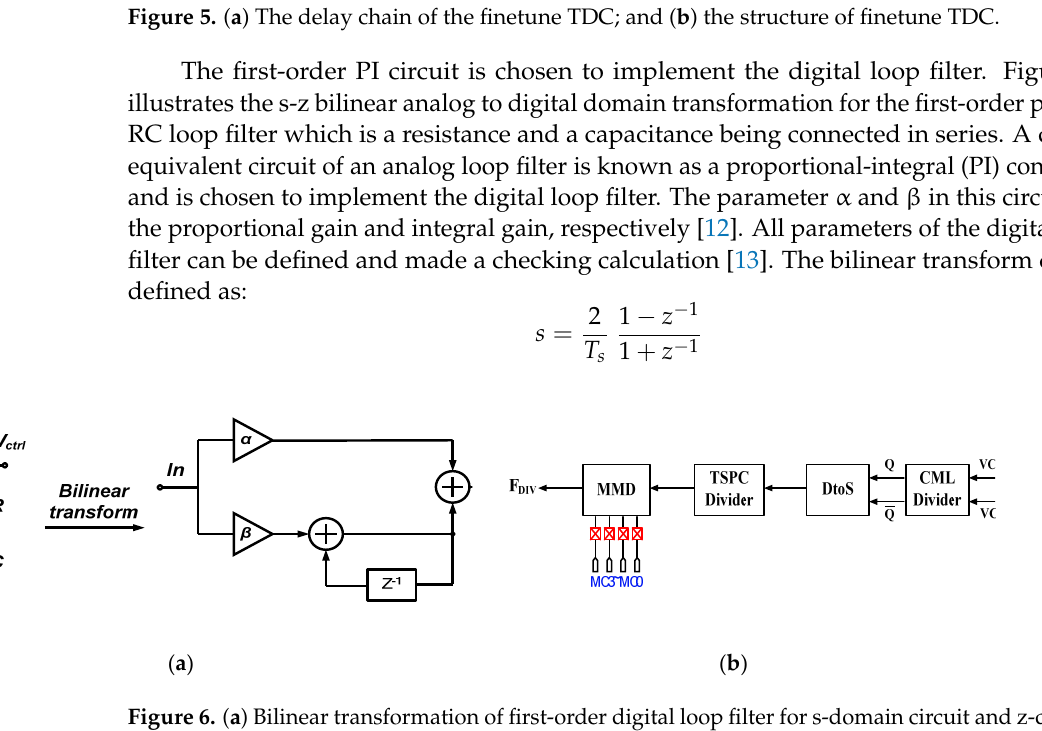
Figure 6. ( a ) Bilinear transformation of first-order digital loop filter for s-domain circuit and z-domain circuit.; and ( b ) the proposed programmable divider